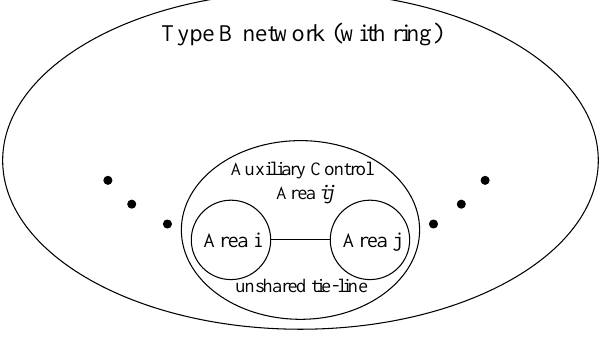
Figure 7. Diagram of the auxiliary control